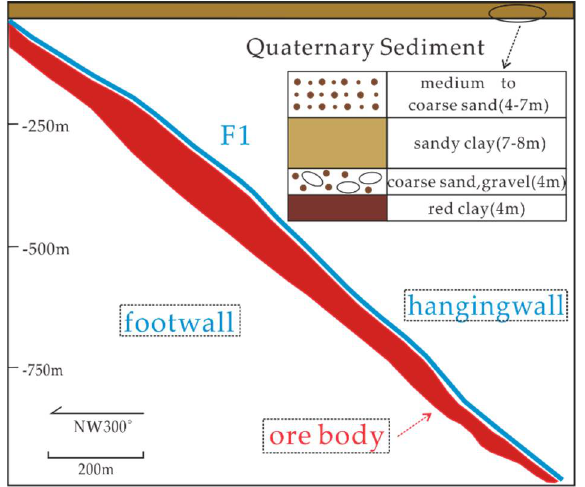
Figure 3 . The simplified geological cross-section of the study area .